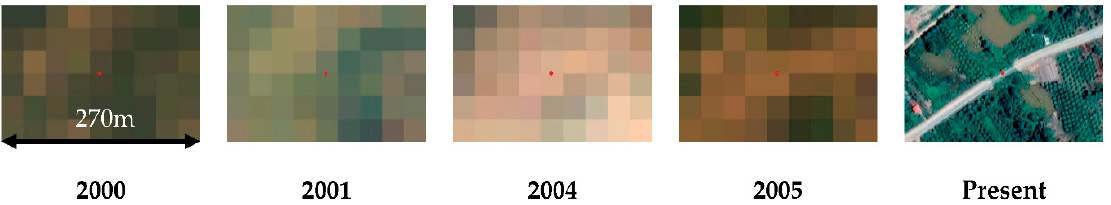
Figure 22. Satellite images of the Prek Ah Teang bridge from which the year of construction cannot be judged.